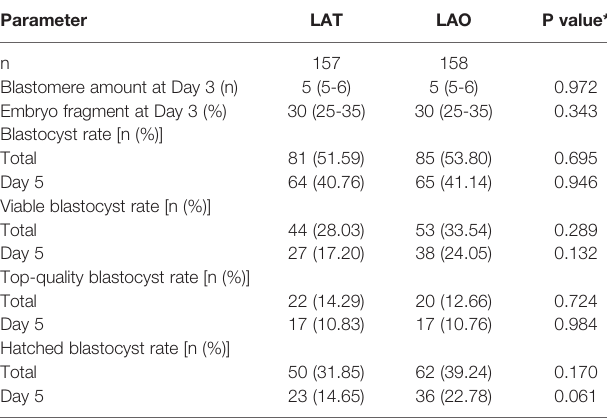
TABLE 2 | Characteristic and blastocyst cultural outcome between the two